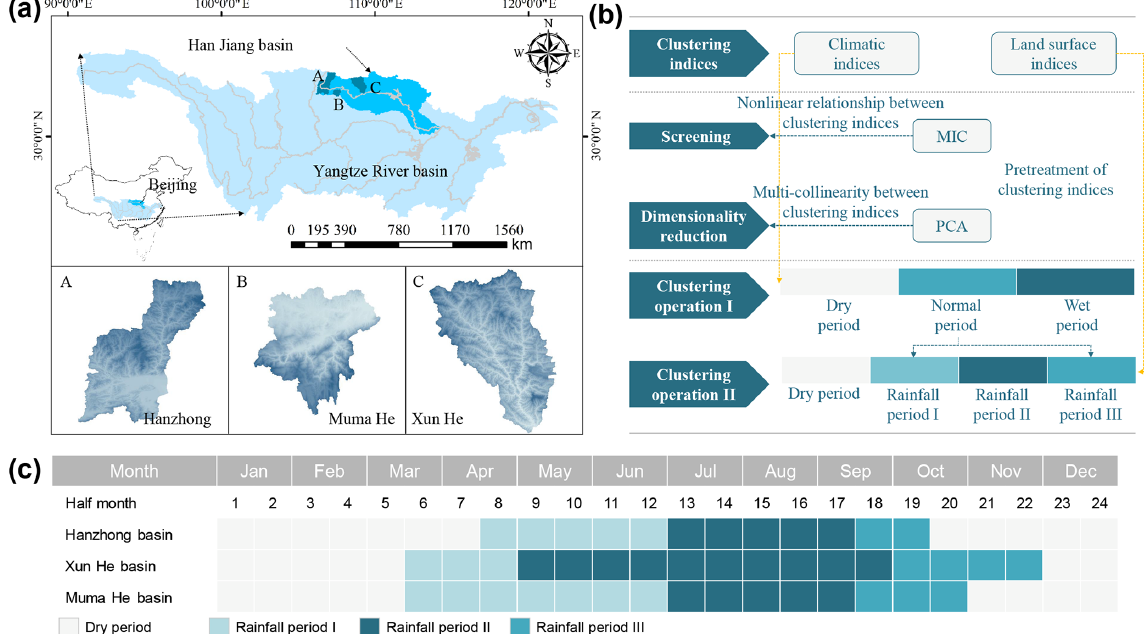
Figure 1. Study cases and data. (a) Locations of the study region, the Han Jiang and its three major tributaries considered in this study, i.e., the Hanzhong, Muma He and Xun He. (b) Flowchart of the sub-period partition using the CPP framework. (c) Heat map of sub-period partition. Note that the sub-periods include the dry period, rainfall period I, rainfall period II and rainfall period III. In the dry period, both the total amount and the variance values of all the precipitation series reach the minimum. In contrast, the total amount and the variance values of the precipitation series in rainfall period II (wettest period) reach the maximum, and the frequency of heavy rain is highest. In the two normal sub-annual periods (rainfall period I and rainfall period III), the climatic patterns are similar, but the streamflow volume is higher in rainfall period III than in rainfall period I. The reason is that higher antecedent soil moisture content contributed to the higher runoff in rainfall period III than in rainfall period I. More detailed descriptions of the clustering are described in Lan et al.